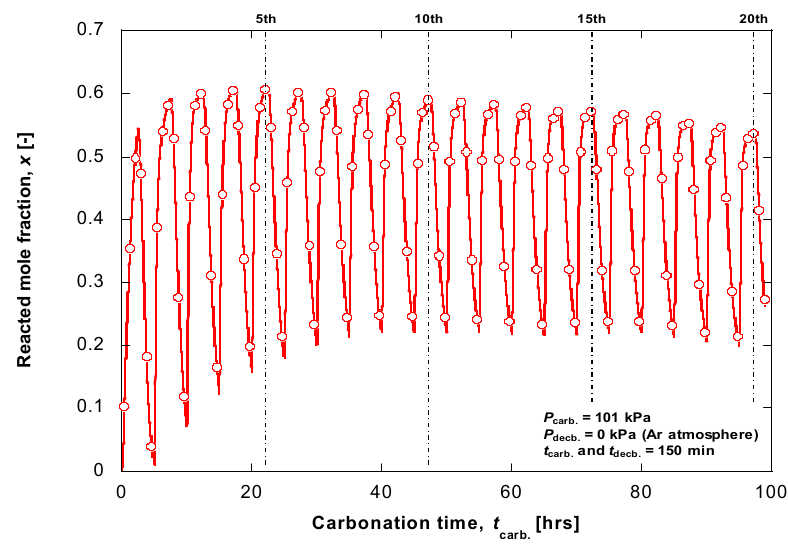
Figure 11. Cyclic experimental result for (LiK)NO 3 /MgO composite ( α = 0.20) at 330 °C.